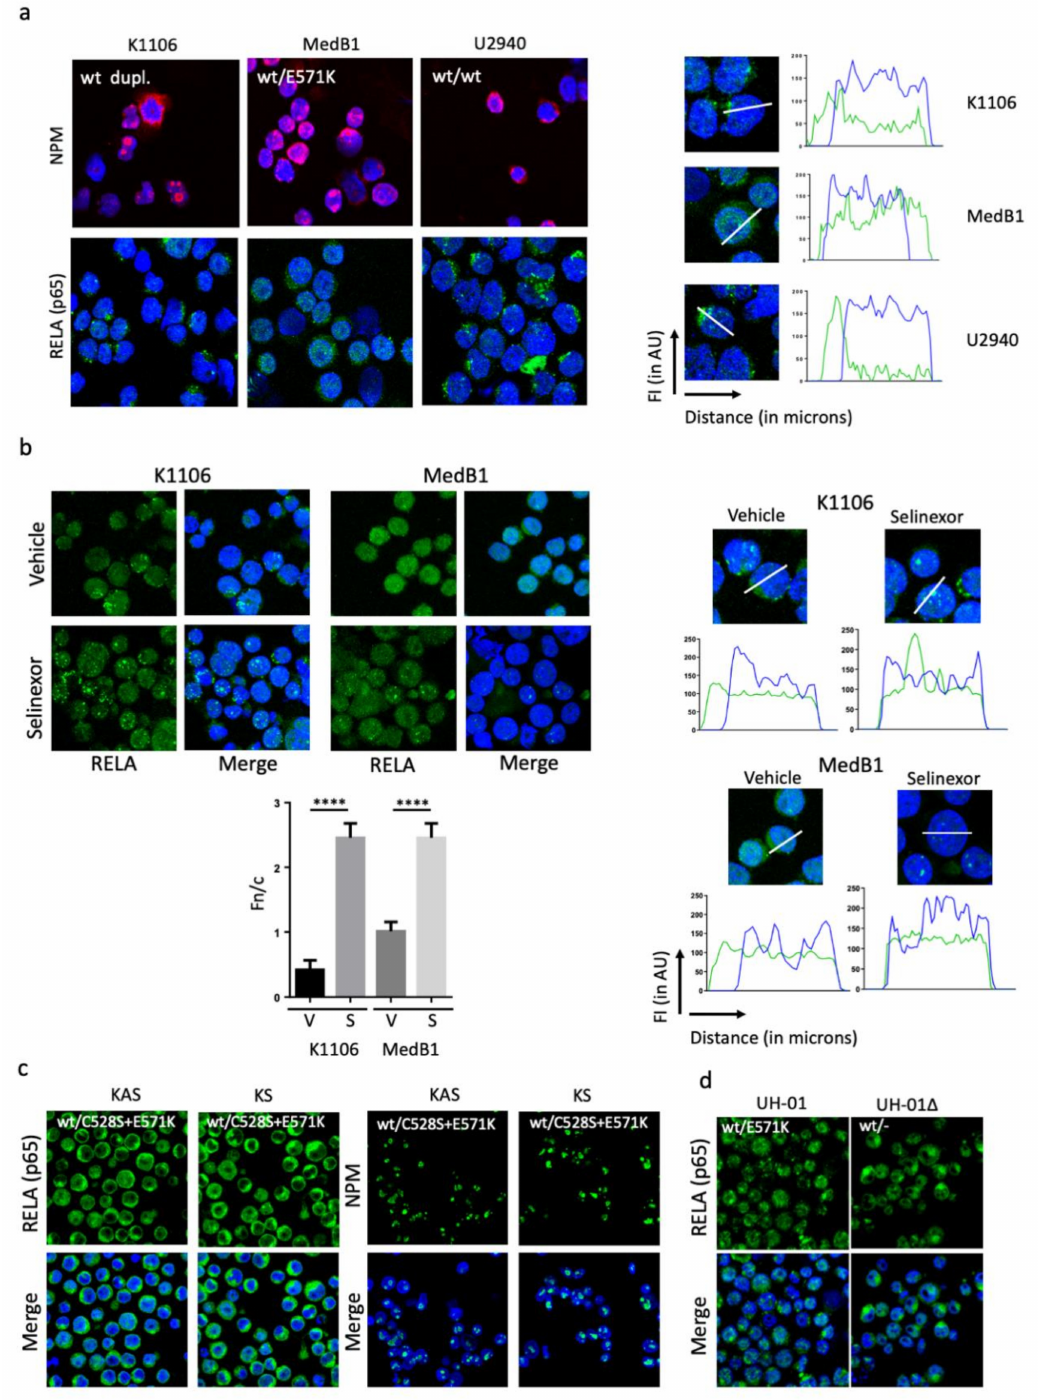
Figure 3. XPO1 is fully functional in PMBL cells. ( a ) PMBL cells were analysed by IF to determine the localisation of two XPO1 cargoes, NPM and RELA. We used primary Abs (Table S7) and a